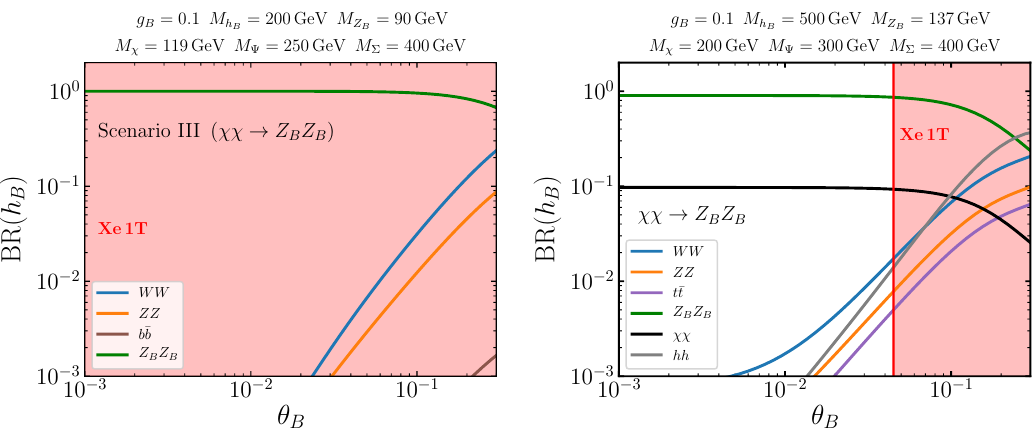
Figure 6 . Branching ratios of the Baryonic Higgs h B as a function of the scalar mixing angle θ B in the context of Scenario III, where χχ → Z B Z B is the dominant annihilation channel. The relevant parameters have been fixed as indicated in the plot to satisfy the dark matter relic density Ω h 2 = 0 . 12 . The different colors correspond to different decay channels as shown in the plot. The area shaded in red is ruled out by